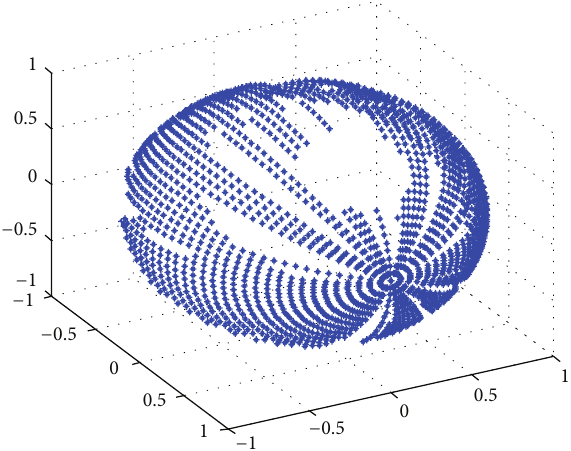
Figure 10: Reached attitude of initial position.